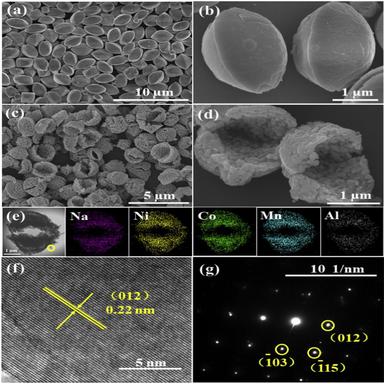
FESEM images of (a, b) the Oxalate precursor and (c, d) walnut-shell-like NaNCMA-3 sample, (e) TEM image and the corresponding EDS mapping of one walnut-shell-like NaNCMA-3 particle. (f) HRTEM image and (g) the corresponding SAED pattern of the selected area in (marked with yellow circle). (For interpretation of the references to colour in this figure legend, the reader is referred to the Web version of this article.)